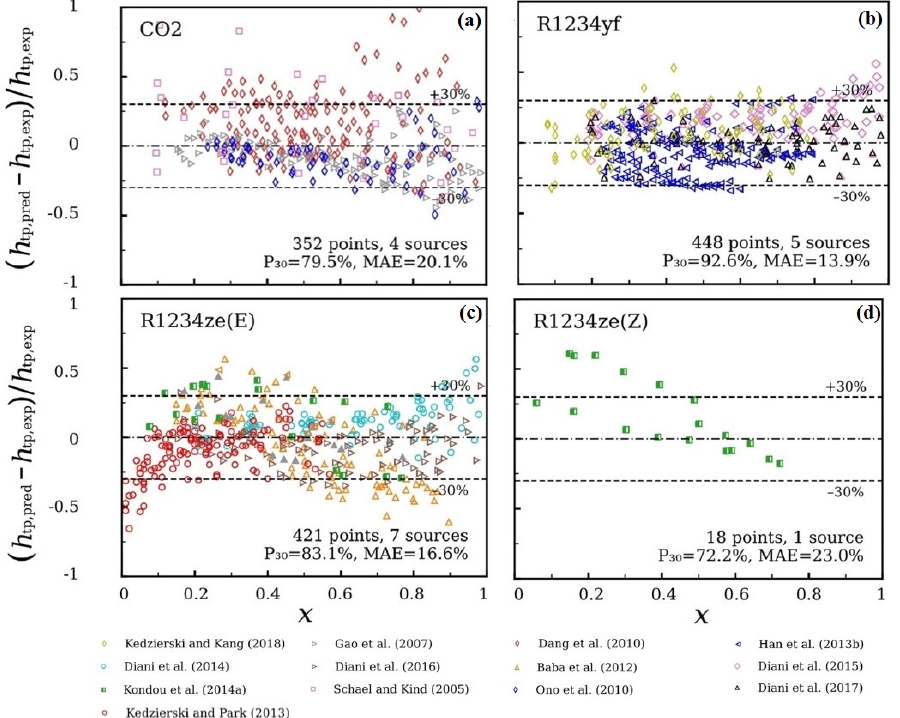
Figure 10. Comparison of different models on the basis of relative residuals to Lin et al. [120] model versus vapor quality for refrigerants ( a ) CO 2 , ( b ) R1234yf, ( c ) R1234ze(E), and ( d ) R1234ze(Z). Energies 2023 , 16 , x FOR PEER REVIEW